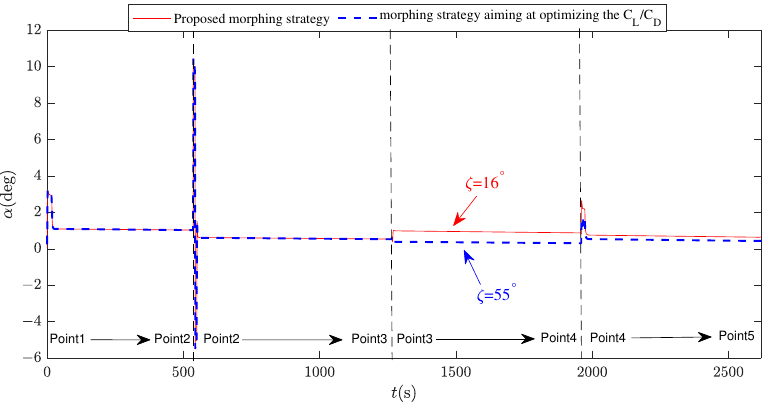
Figure 21. Cruise angle of attack of the comparative simulation in Section